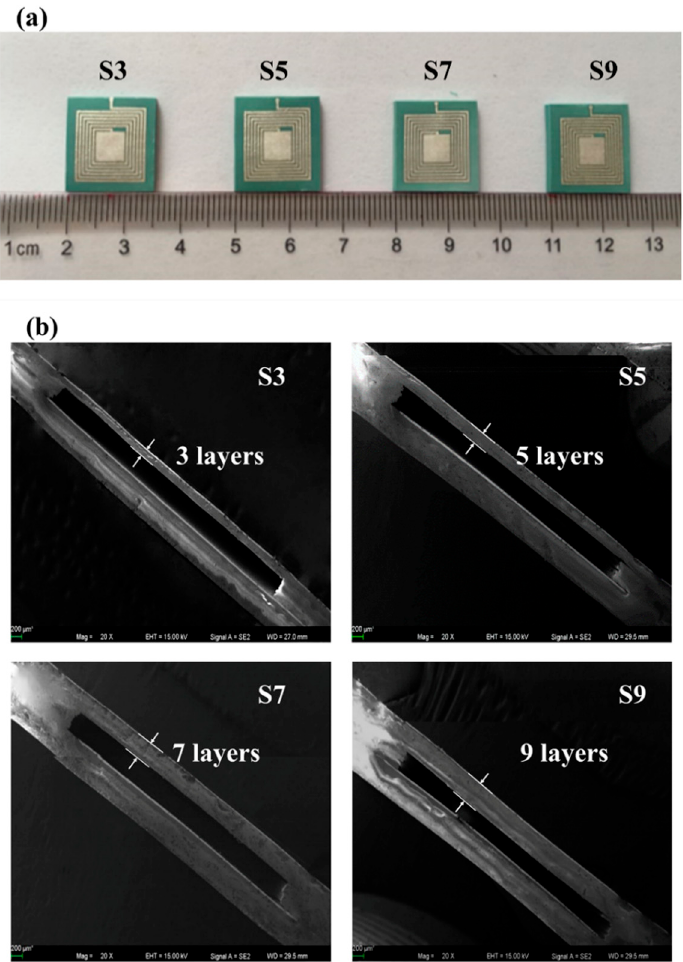
Figure 6. ( a ) Photograph of pressure sensor samples. ( b ) SEM images of the fracture section of the pressure sensors with different sensing membranes thicknesses.